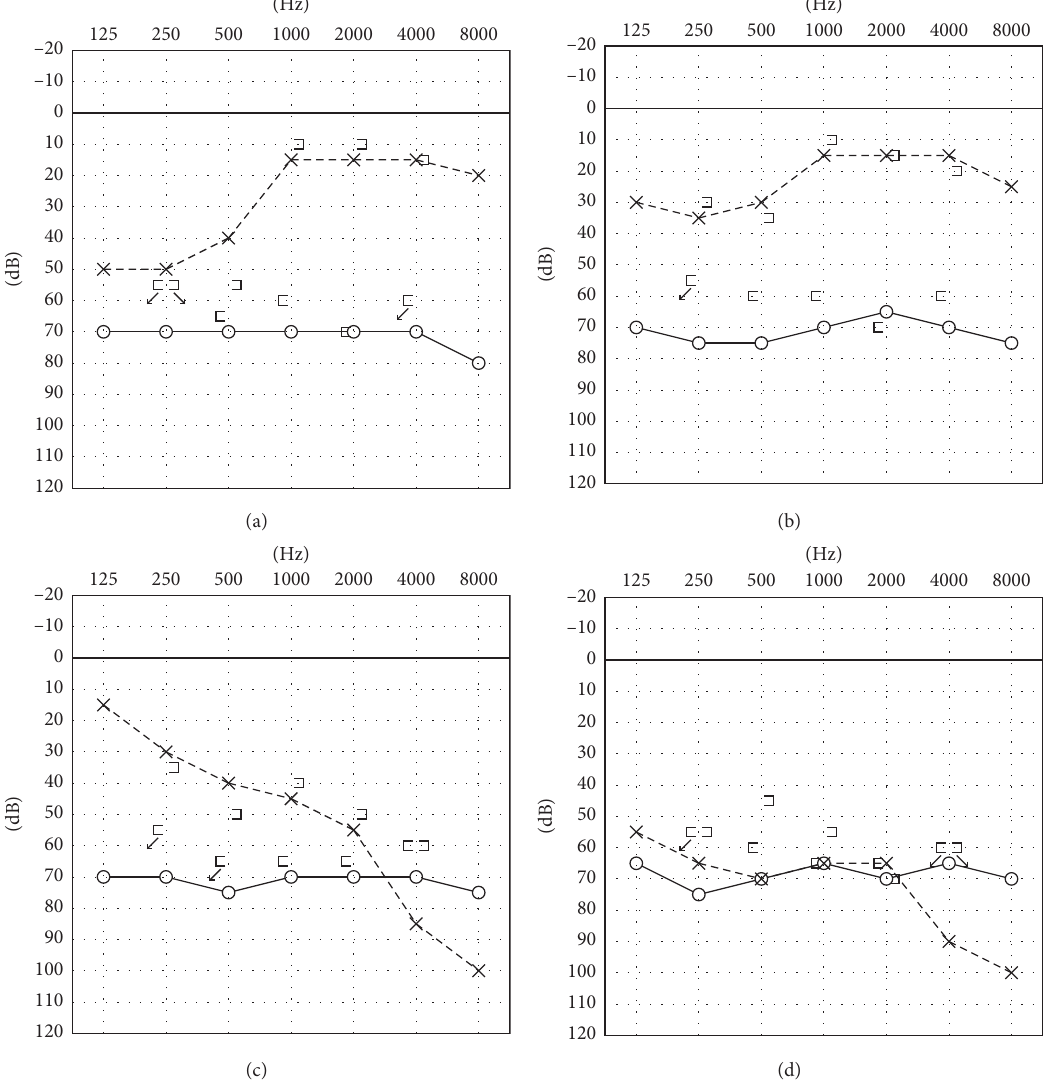
Figure 1: Pure tone audiometry of case 1 before surgery (left ear). (a) Low-tone sensorineural hearing loss (21.3dB). (b) Hearing had once gotten better (13.8dB). (c) Exacerbations and remissions (46.3 dB). (d) The hearing suddenly worse (66.3